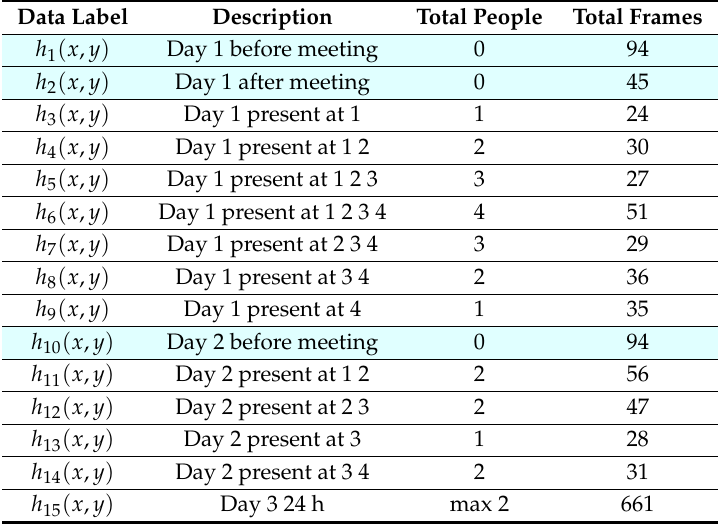
Figure 2. ( a ) The meeting room where the test data streams were collected. The sensor was placed at the ceiling, 1.9 m above the table. The seat numbers correspond to the person presence numbers in Table 1. ( b ) Field of view calculation for the meeting room setup. Table top line corresponds to the black line at the table edge with 90 cm measurement in ( a ). Table 1. Presence sensor recordings used for testing our